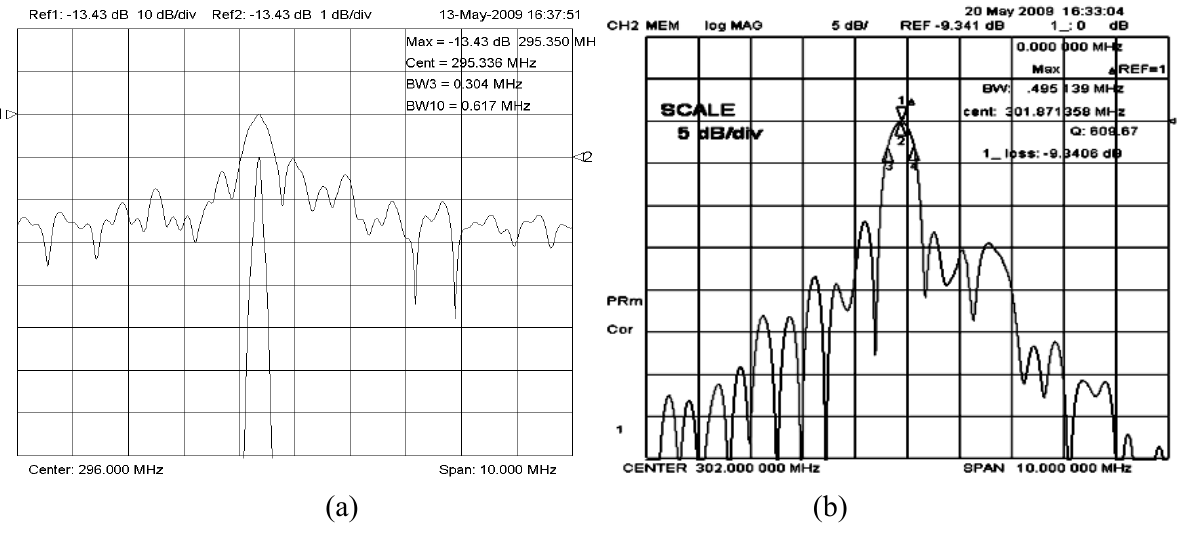
from SAW device with (a) Cr/Au, and (b) Al/Au Figure 5. Measured S 12